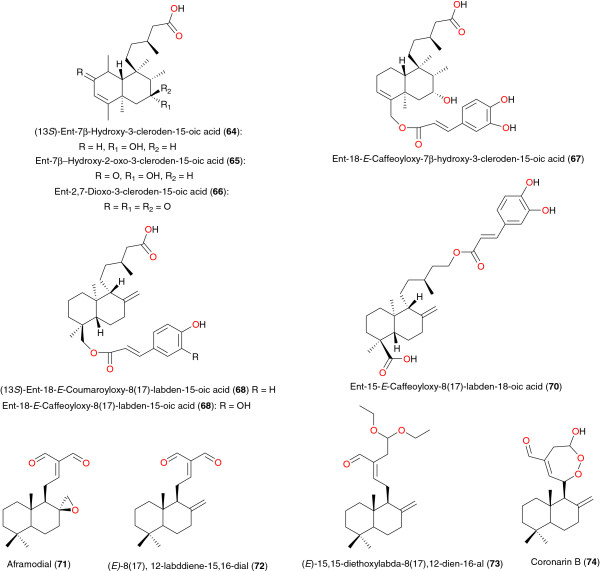
Clerodane and labdane diterpenoids from African medicinal plants with anti-malarial activity - I.